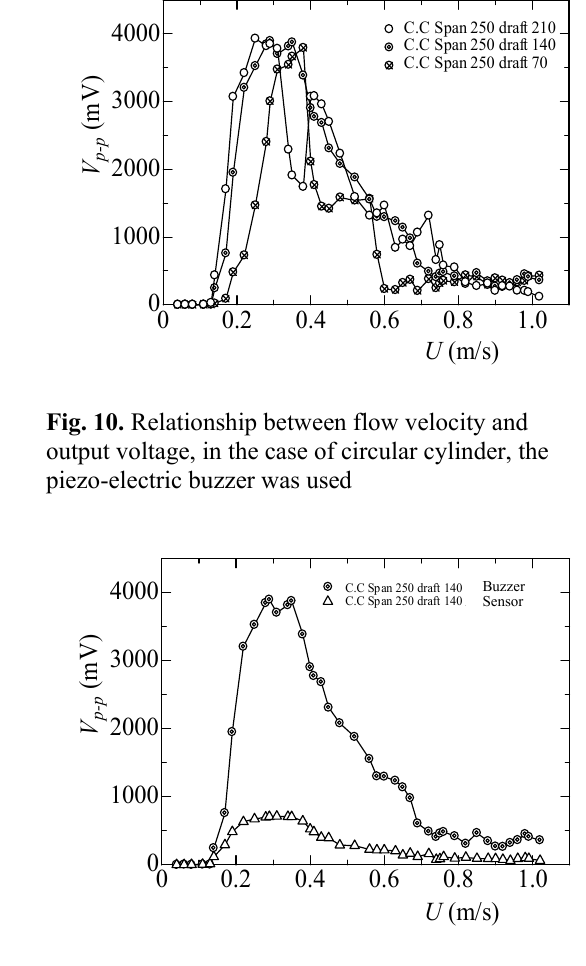
Fig. 11. Relationship between flow velocity and output voltage, in the case of circular cylinder, comparison of the piezo-electric sensor and the piezo-electric